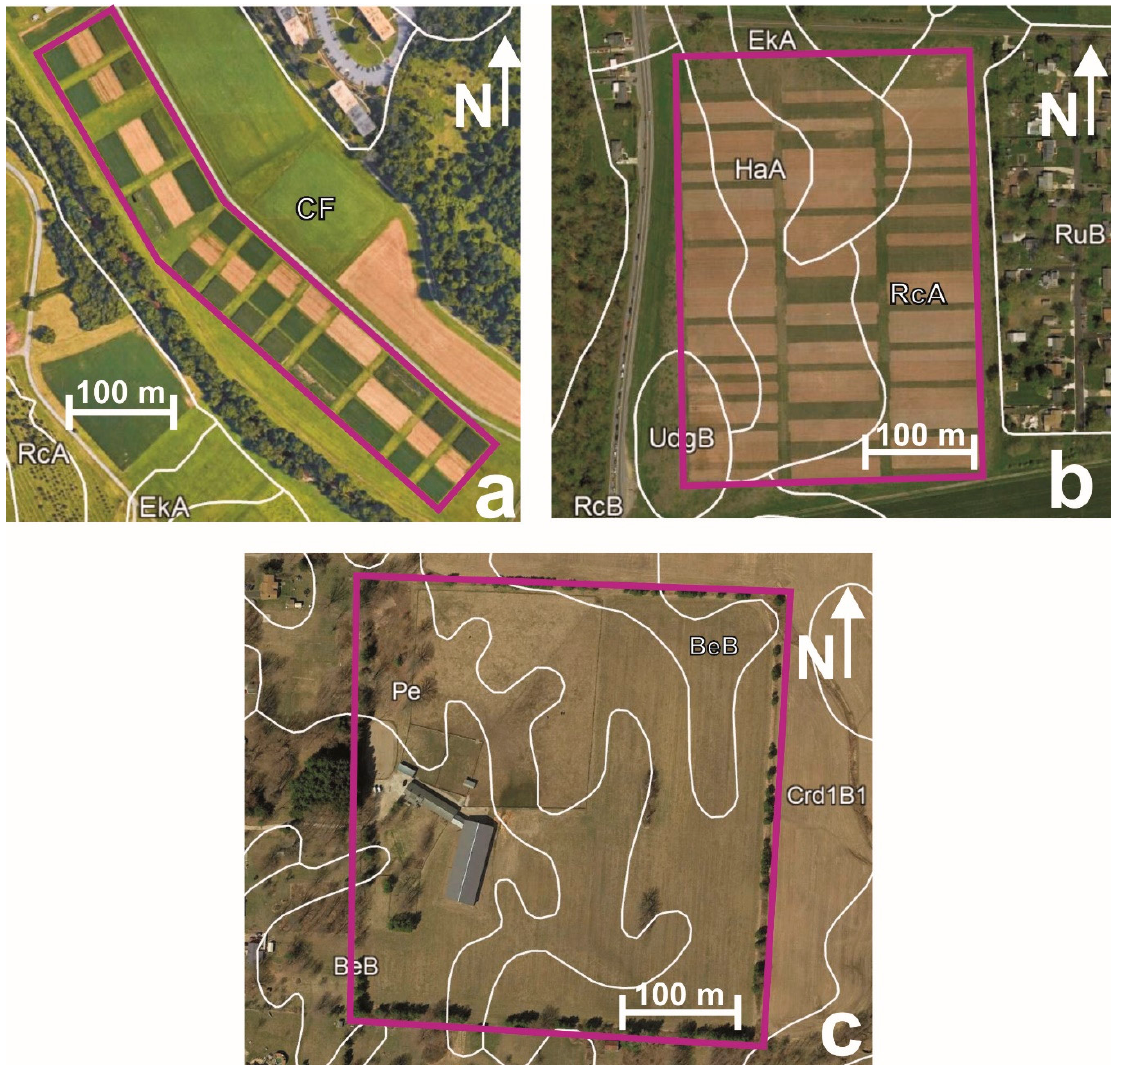
Figure 2. Aerial images with soil map overlays of the three agricultural sites that were investigated with GPR-RTK/GNSS: ( a ) Site 1; ( b ) Site 2; ( c ) Site 3. Purple lines mark site boundaries.